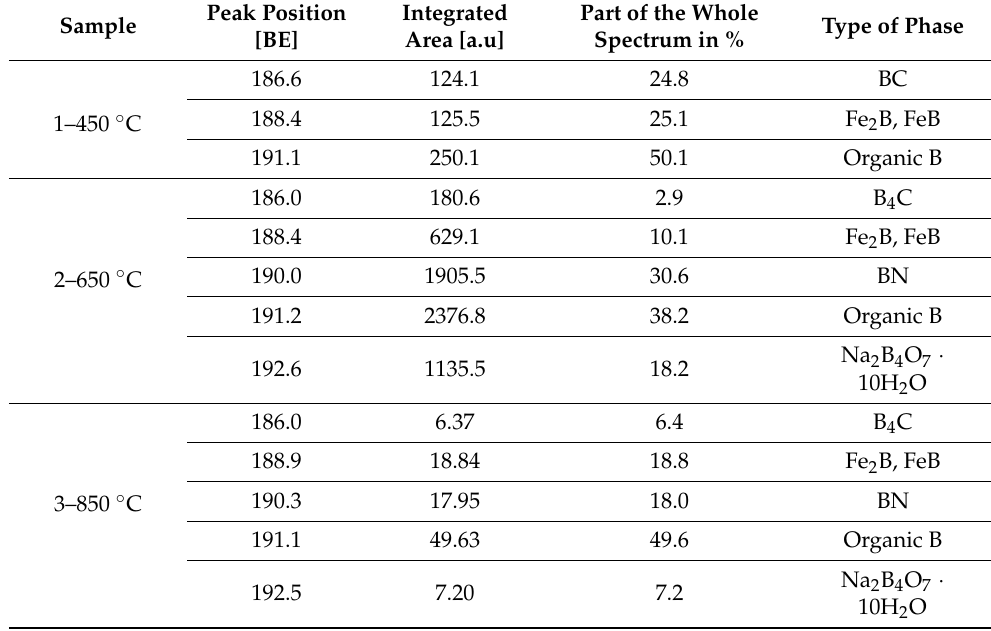
Table 3. Percentage of boron phases in each sample.